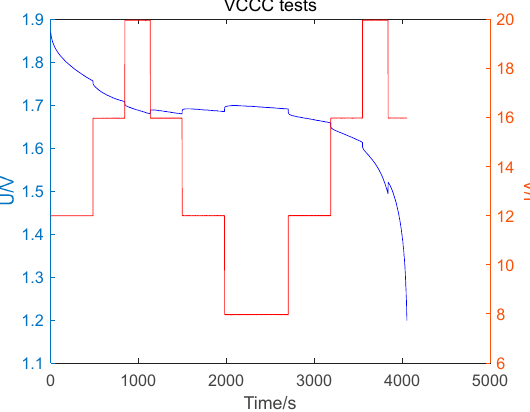
Figure 16. Discharge processes of the VCCC tests.